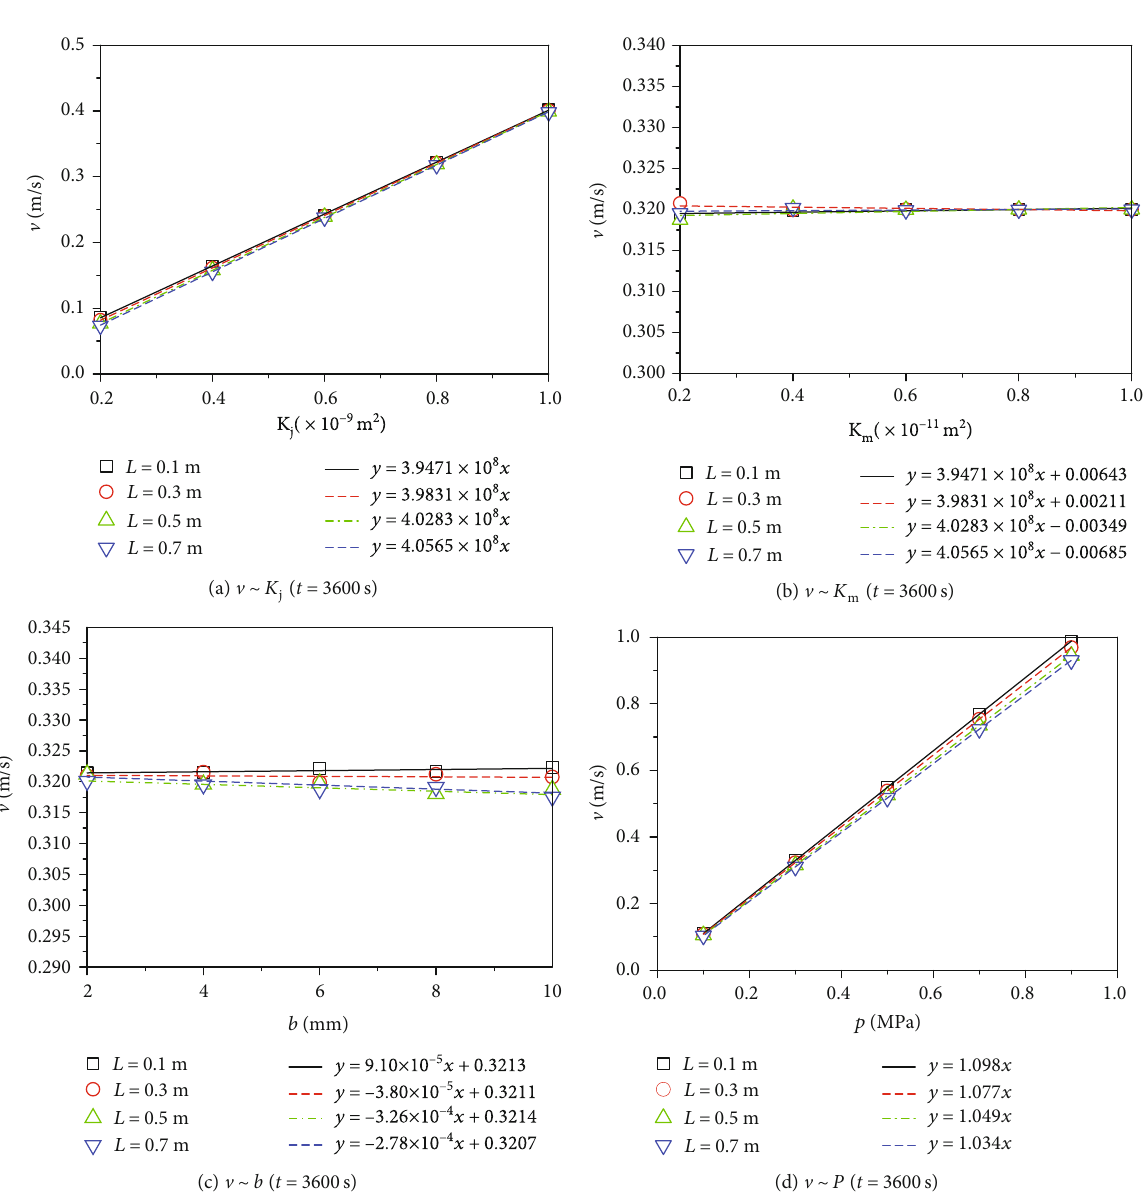
Figure 17: Regression analysis of v as a function of K